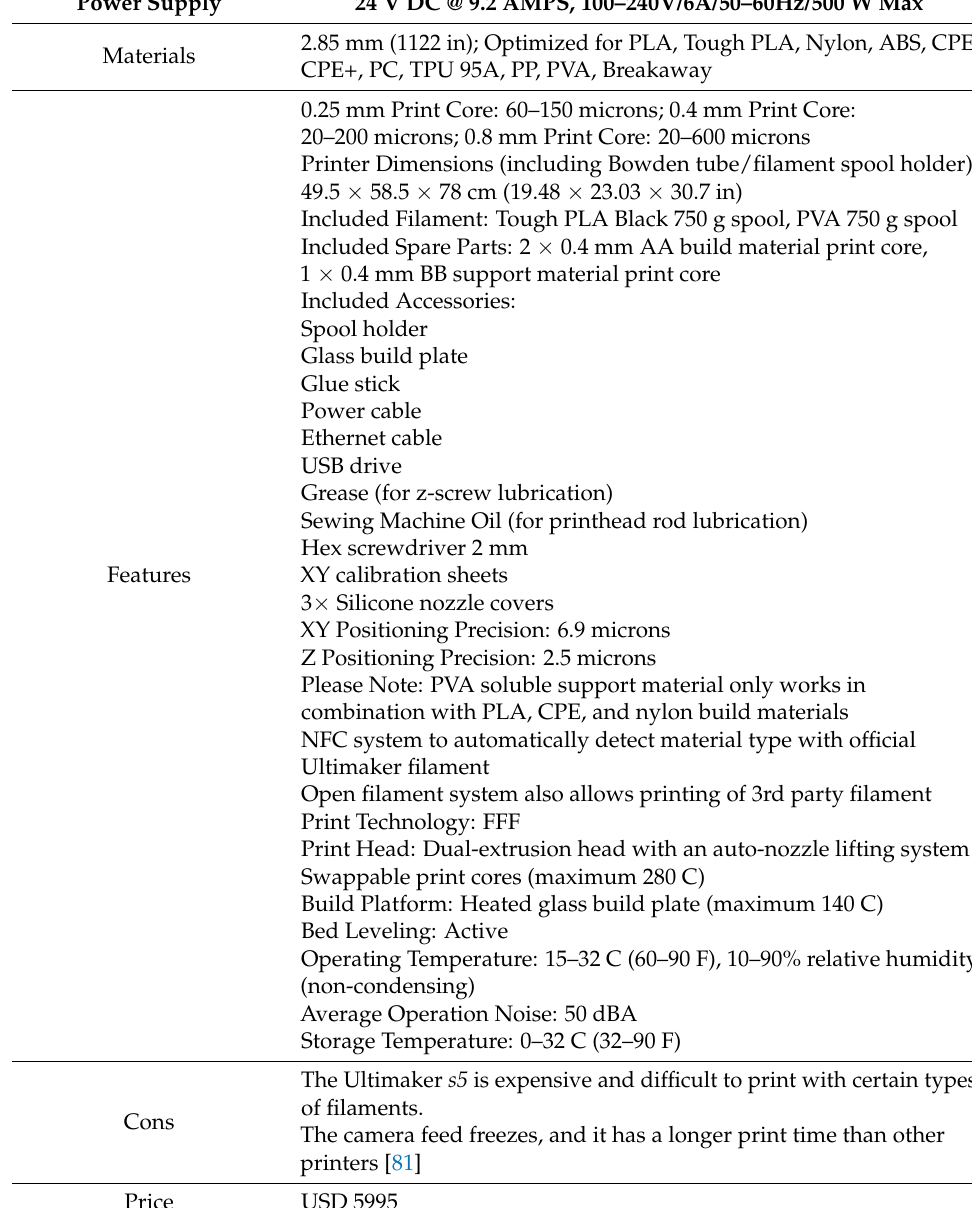
Table 11. Descriptions of Makerbot Ultimaker S5 Desktop 3D